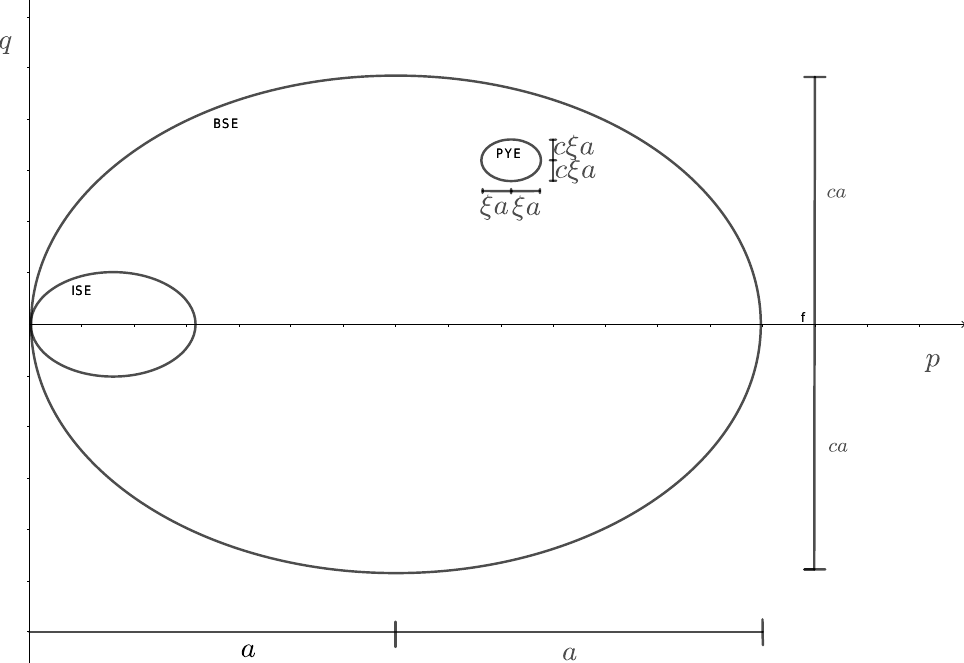
Figure 1. Generalised form of the modified Cam-Clay yield surfaces considering elastoplastic behaviour in the p–q plane. a is the halfsize of the large diameter of BSE and ξ is a similarity factor, while c is the critical state line inclination. BSE and PYE are the abbreviations for Bond-Strength Envelope and Plastic Yield Envelope,